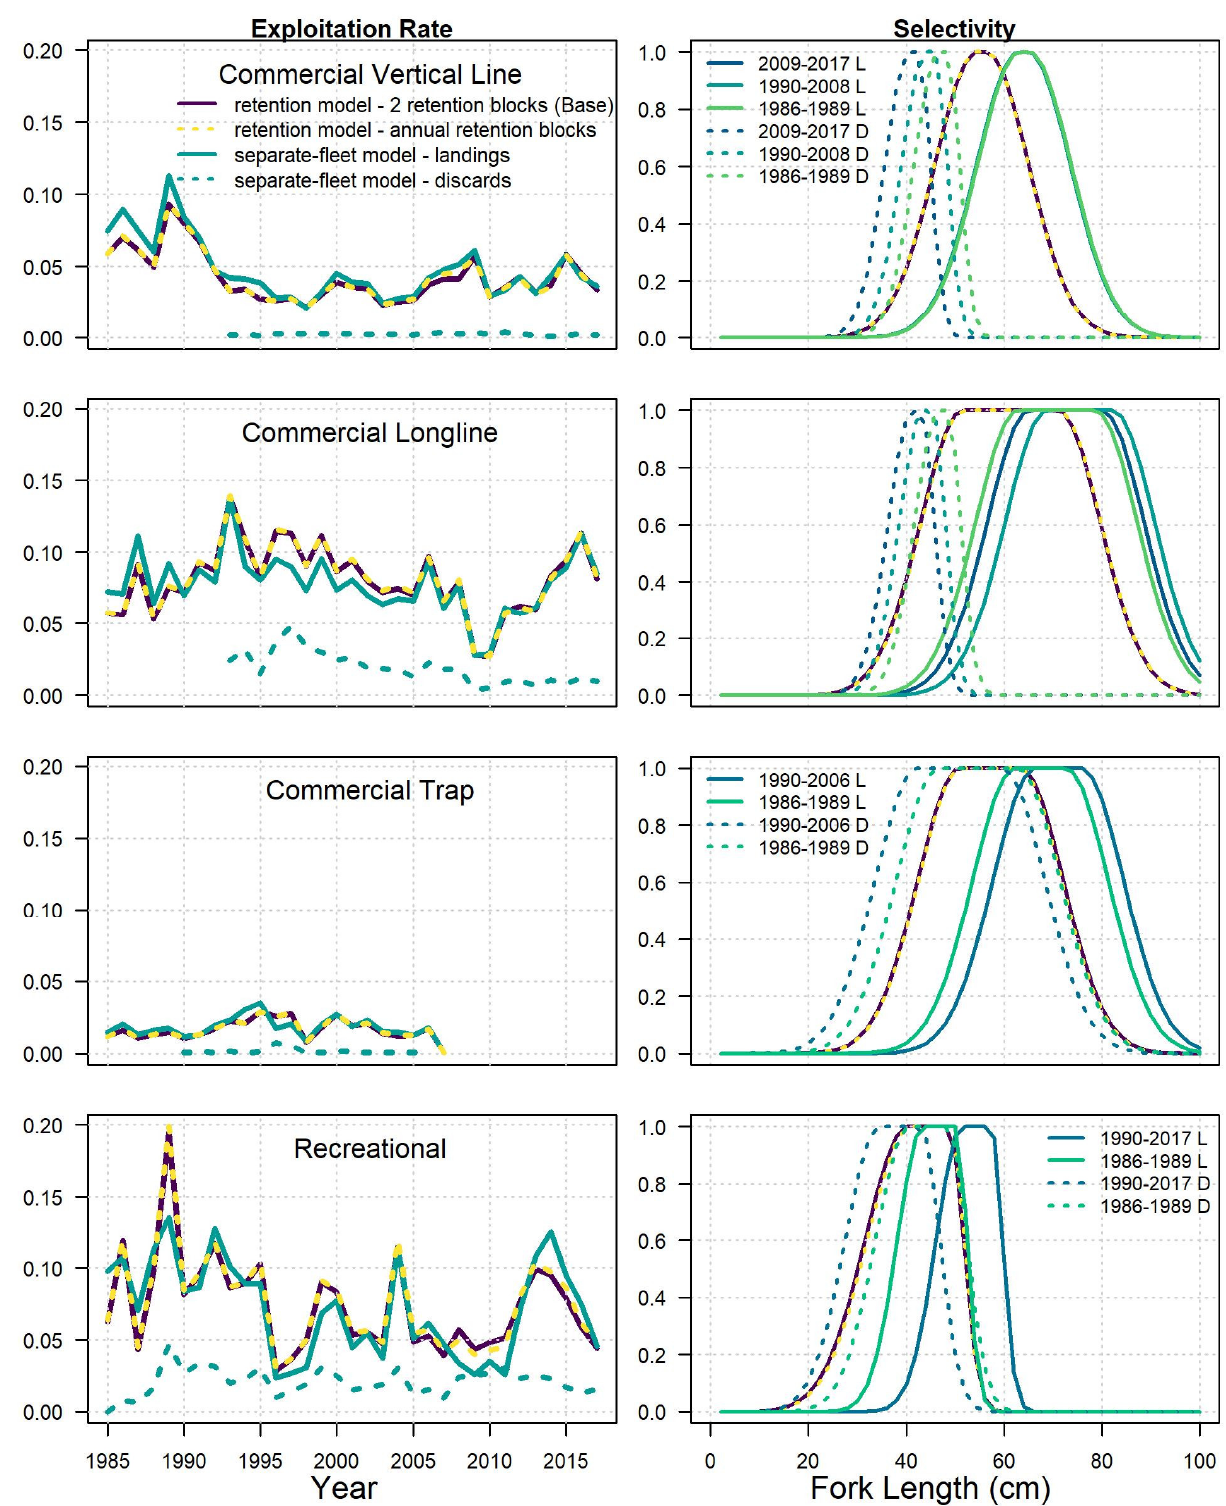
Figure 6. Comparison of estimated exploitation rates (total biomass killed/total biomass) and estimated length-based selectivity patterns by fishery for each Gulf red grouper model implementing different approaches to including discards. Selectivity time blocks are for landings (L) or discards (D).